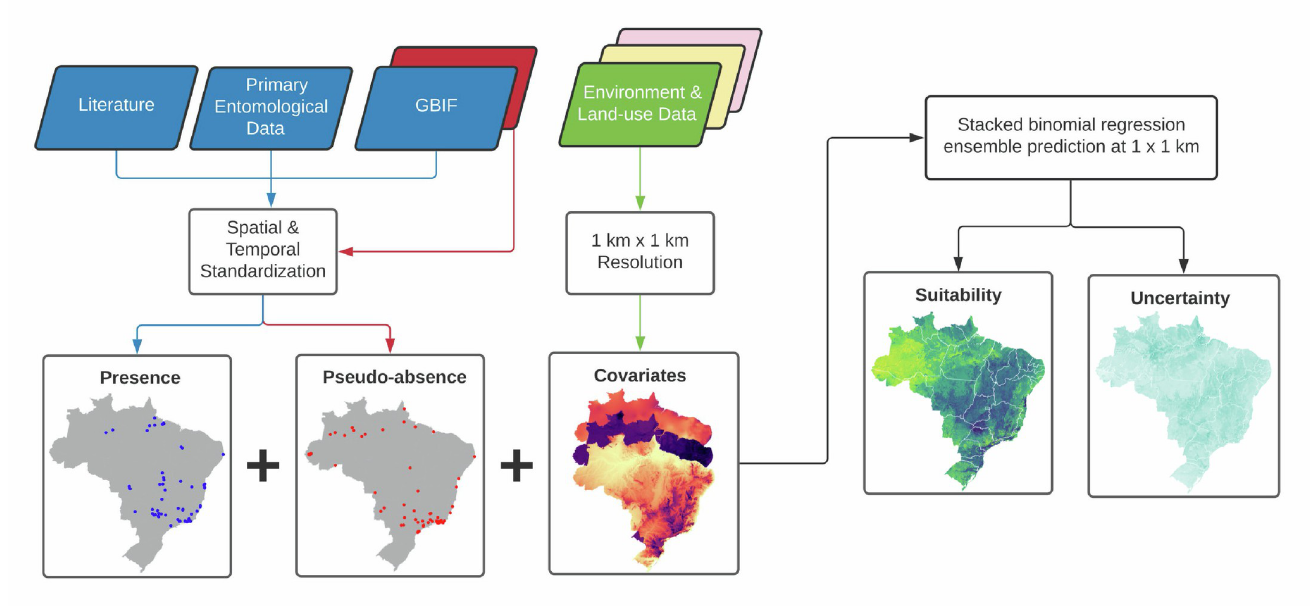
Fig 1. Schematic diagram of the modelling approach adopted to produce maps of environmental suitability for Haemagogus spp . and Sabethes spp . at 1 km x 1 km resolution. The base layer of the map was retrieved from https://www.ibge.gov.br/geociencias/downloads-geociencias.html.